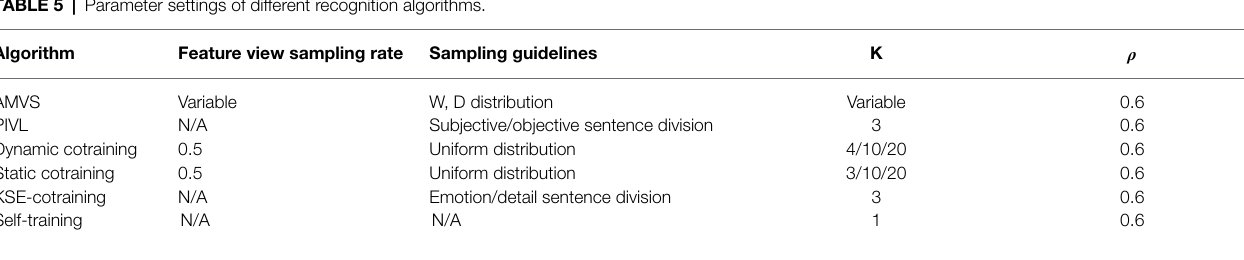
TABLE 5 | Parameter settings of different recognition